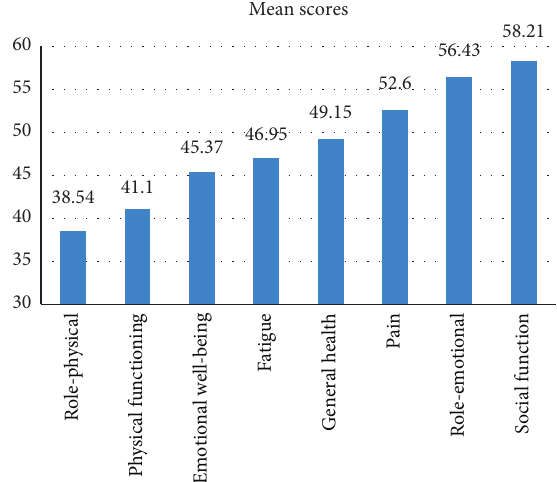
Figure 1: Level of burden in each item of quality of life. Table 2: Kidney Disease Quality of Life Scale, definition, and its items.